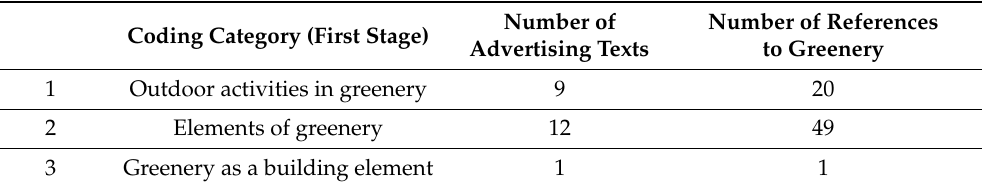
Table 3. The number of advertising websites that present greenery in a written material in the three coding